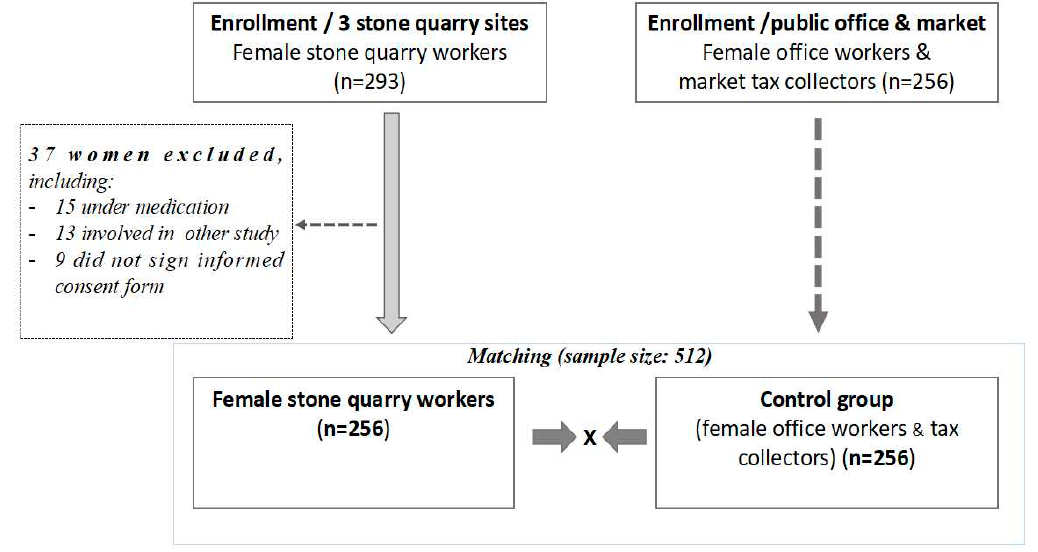
Figure 2. Diagram showing the sampling process of study participants.